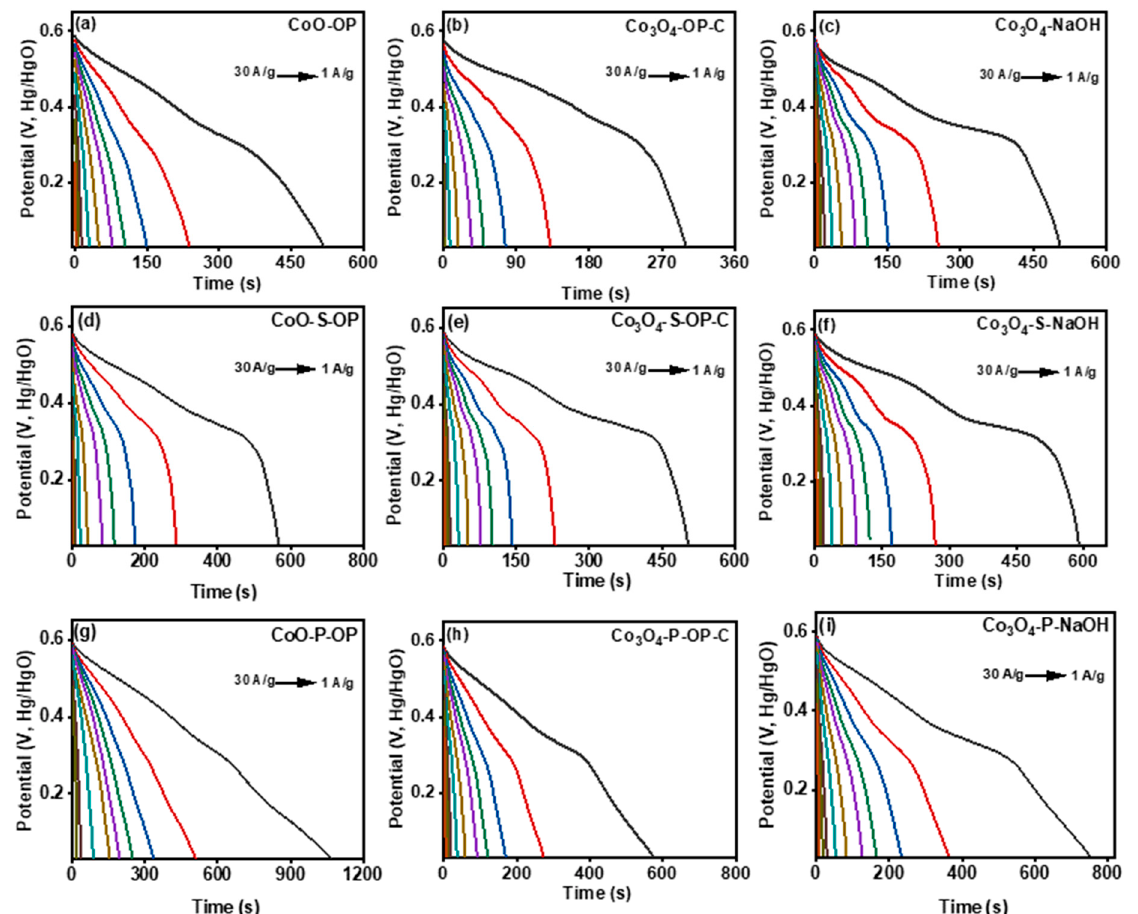
Figure 5. The discharge curves of the prepared ( a ) CoO-OP, ( b ) Co 3 O 4 -OP-C, ( c ) Co 3 O 4 -NaOH, ( d ) Co 3 O 4 -S-OP, ( e ) Co 3 O 4 -S-OP-C, ( f ) Co 3 O 4 -S-NaOH, ( g ) CoO-P-OP, ( h ) Co 3 O 4 -P-OP-C, ( i ) Co 3 O 4 -P-NaOH, nanoparticles, from current density 30 A/g to 0.5 A/g. The GCD for all the samples are performed at various current density ranging from